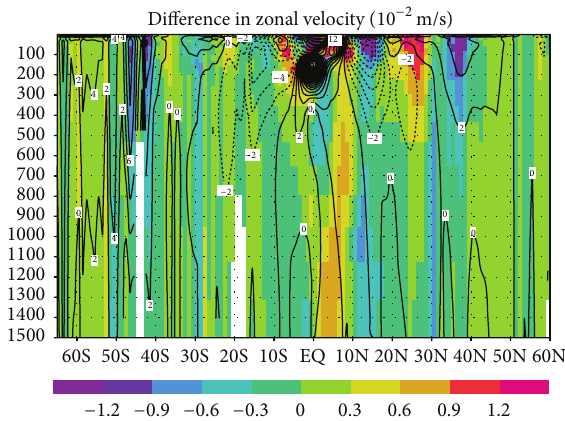
Figure 4: Difference in mean zonal velocity ( 10 −2 ms −1 ) during 2001–2007 between GY and CT cases (color) and mean value for the CT case (contours) in a 1500 m vertical cross section along longitude 180 ∘ .